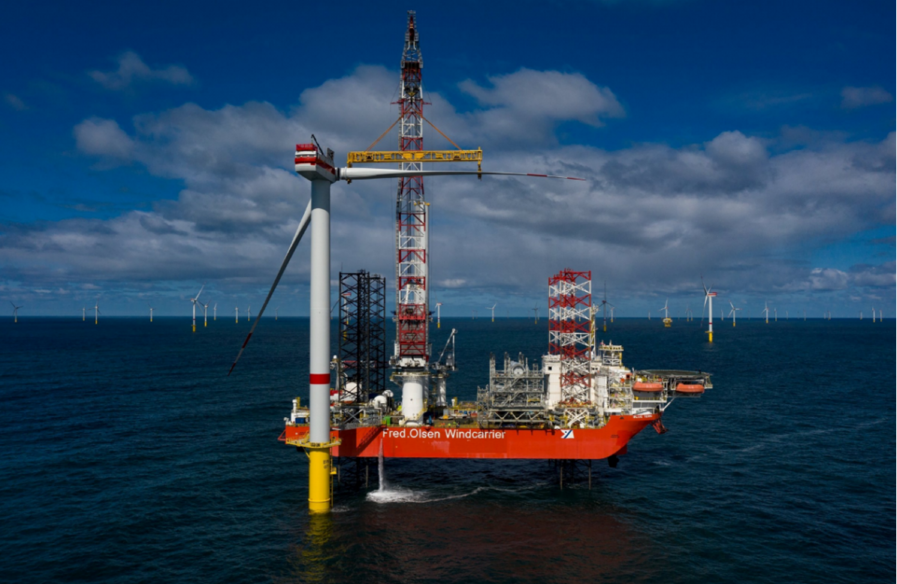
Figure 2. Blade installation taking place at Trianel Windpark Borkum